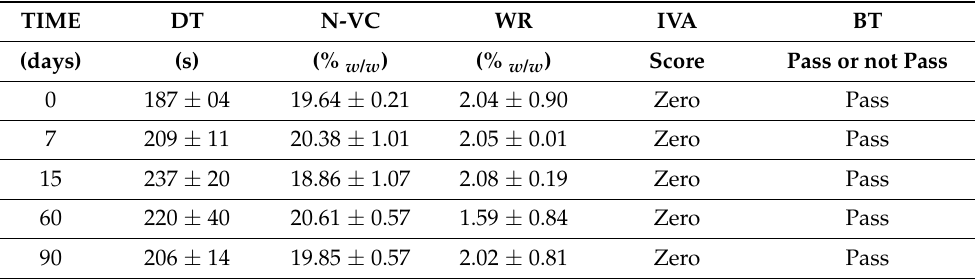
Table 3. Physicochemical characterization of the AmB-loaded nail lacquer.